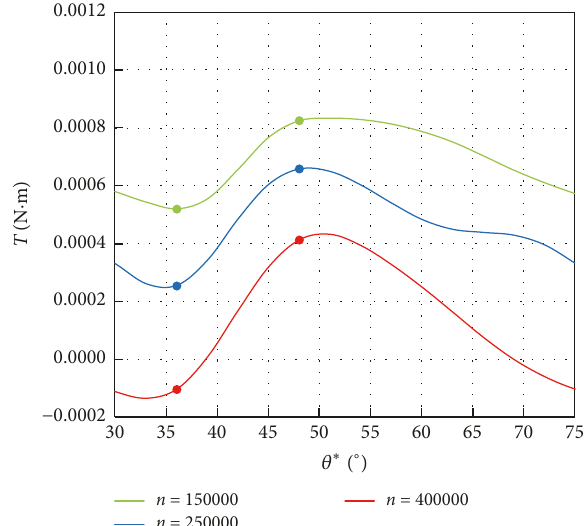
Figure 15: Torque fluctuation for one blade pitch.